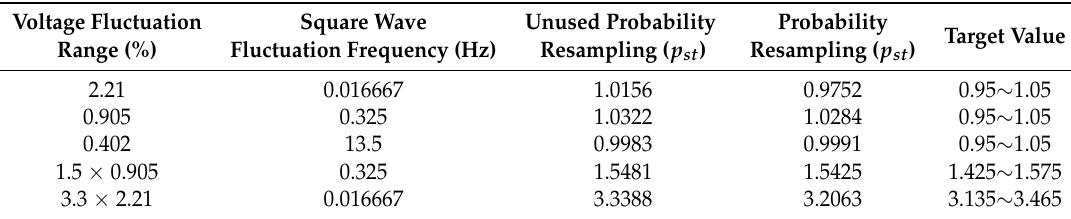
Table 1. Simulation results of p st .